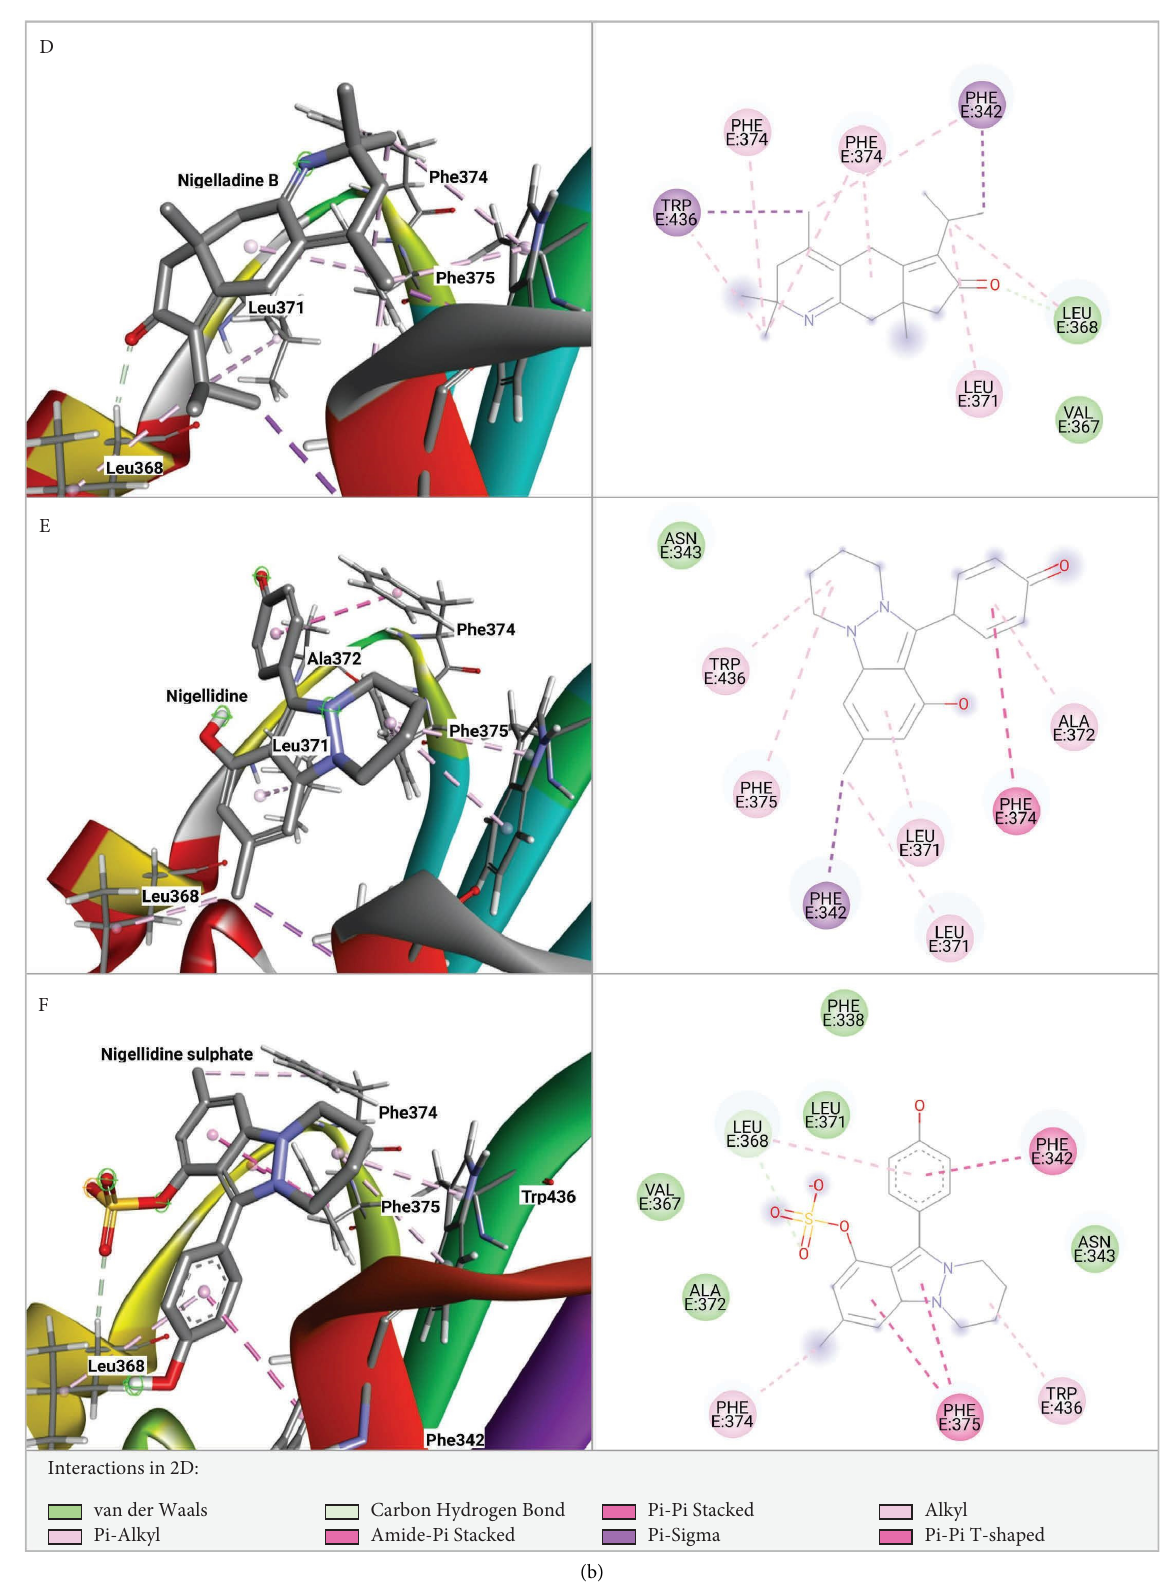
Figure 1: Docked conformations (3D and 2D) of spike protein with (A) dithymoquinone, (B) kaempferol, (C) Nigelladine A, (D) Nigelladine B, (E) Nigellidine, and (F) Nigellidine